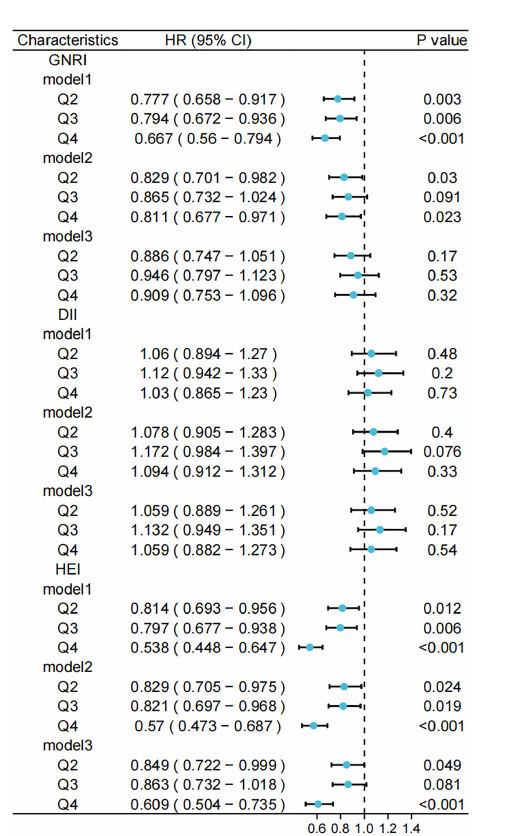
in the lowest quartile in the model. This trend was observed in